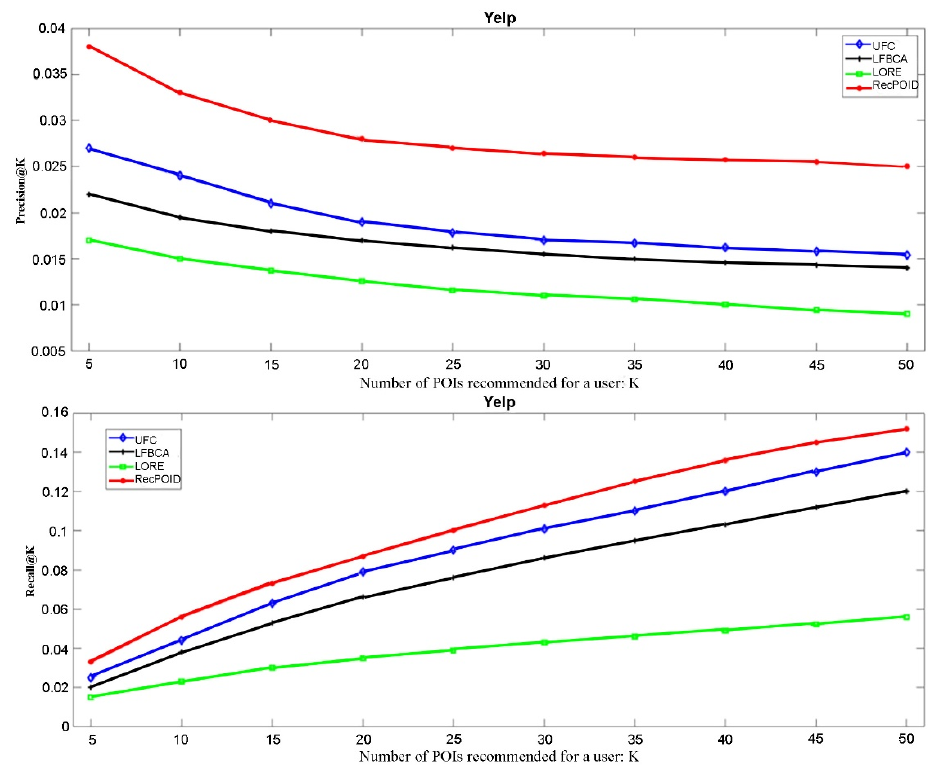
Figure 5. Comparison between RecPOID and the other three methods. Future Internet 2021 , 13 , x FOR PEER REVIEW